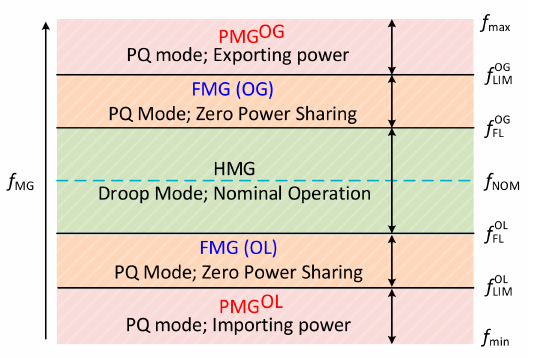
Figure 3. MG status and its different operating modes based on its frequency